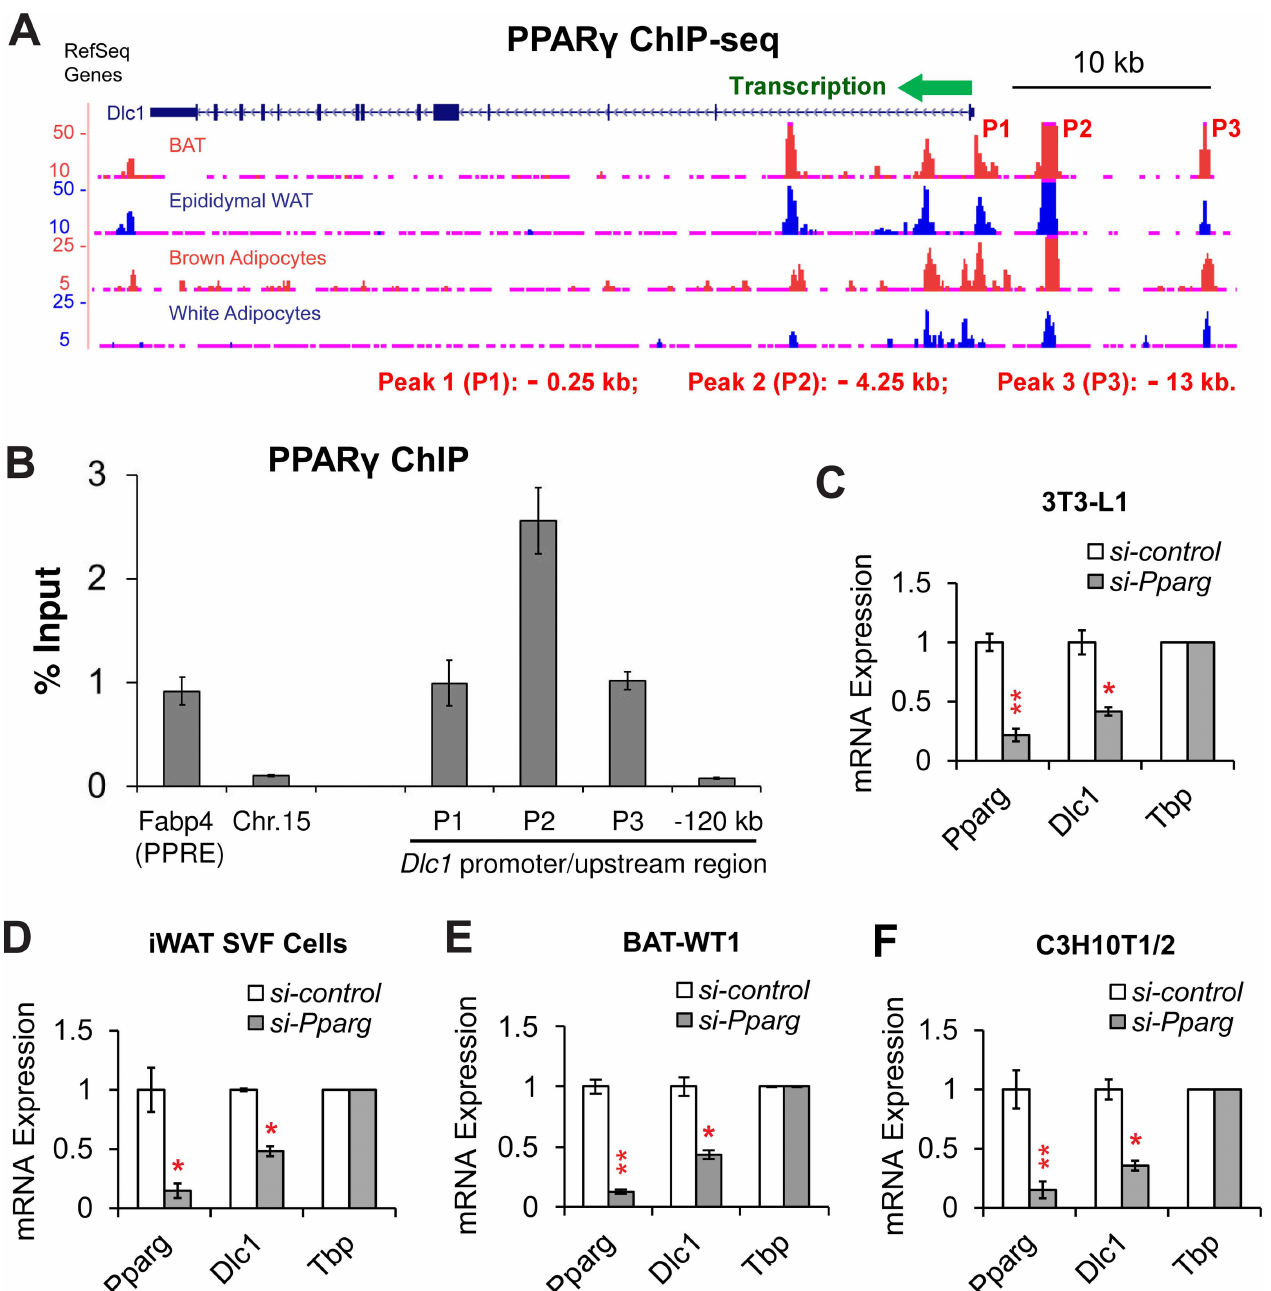
Fig 5. Dlc1 is a Direct Target of PPAR γ .(A) PPAR γ ChIP-seq data revealeddirect bindingof this master regulatorof adipogenesis at the promoter of Dlc1 genein mouse BAT, eWAT, 3T3-L1 white adipocytesand C3H10T1/2 derived brown adipocytes. The positions(Relativeto the transcription start site of Dlc1 gene) of PPAR γ bindingpeaks (P1-P3) are indicatedunder the graph. (B) PPAR γ ChIP confirmedits bindingto Peak 1–3 at the promoter/ upstream regionof Dlc1 gene in C3H10T1/2 cells (Brown adipocytes). Fabp4 gene promoterand a chromosome 15 (Chr.15) regionwere used here as positive/negative controls for PPAR γ ChIP. (C-F) qRT-PCR results showingthe knockdown of Pparg and the reduced expressionof Dlc1 gene in (C) 3T3-L1 white adipocytes, (D) primary iWAT SVF cell derivedwhite adipocytes, (E) BAT-WT1 brown adipocytesand (F) C3H10T1/2 derived brown adipocytes. Data are presentedas mean ± s.e.m. n = 3–6 biologicalreplicates. Two-tailedStudent’s t -test was used: * P < 0.05, ** P <